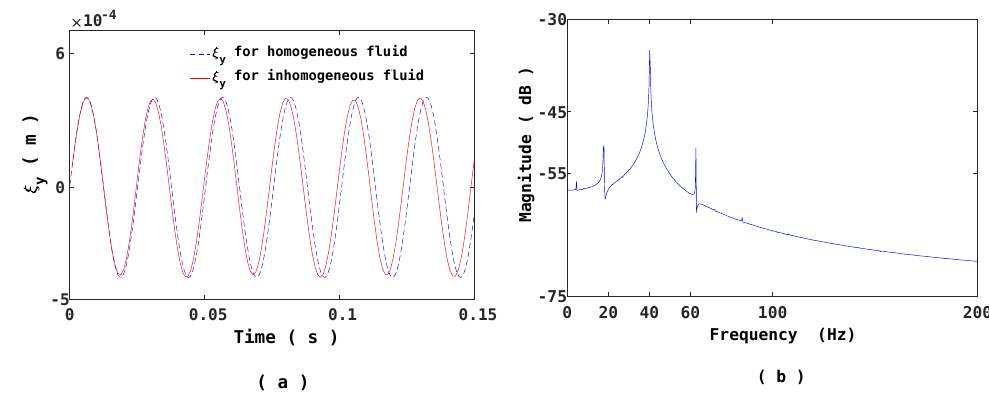
Figure 9. ( a ) Comparison of hydrofoil displacements in homogeneous and non-homogeneous cases. ( b ) Frequency of hydrofoil displacements in non-homogeneous case.